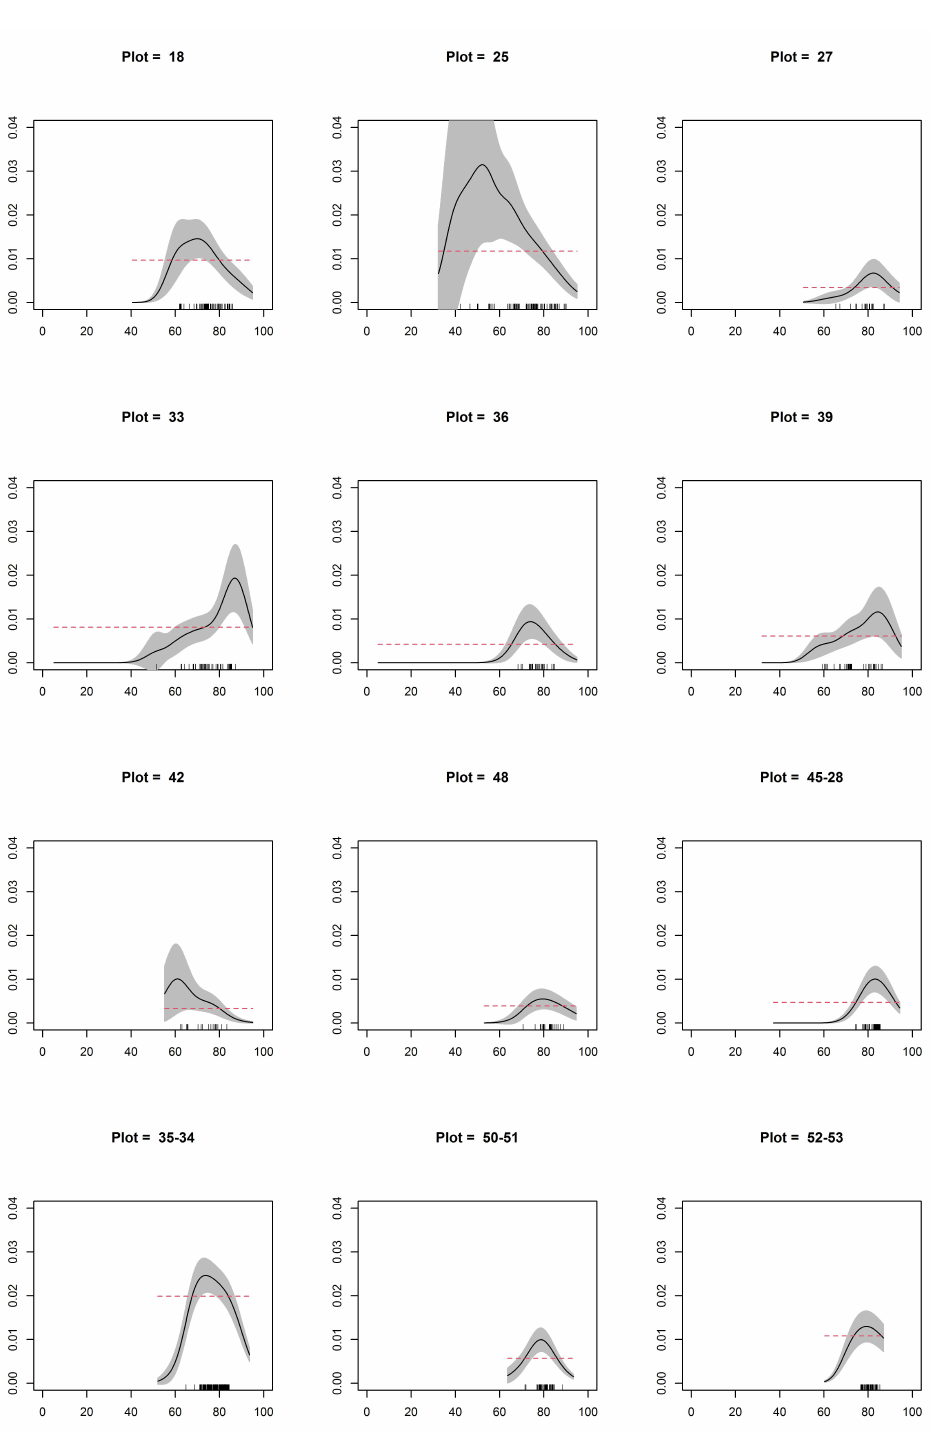
Figure A2. Estimated intensity of regeneration as a function of the canopy cover. The solid black line represents the estimated function ( ρ (z)), the red dotted line represents the mean, and pointwise 95% confidence intervals for the true value are plotted as grey shading.